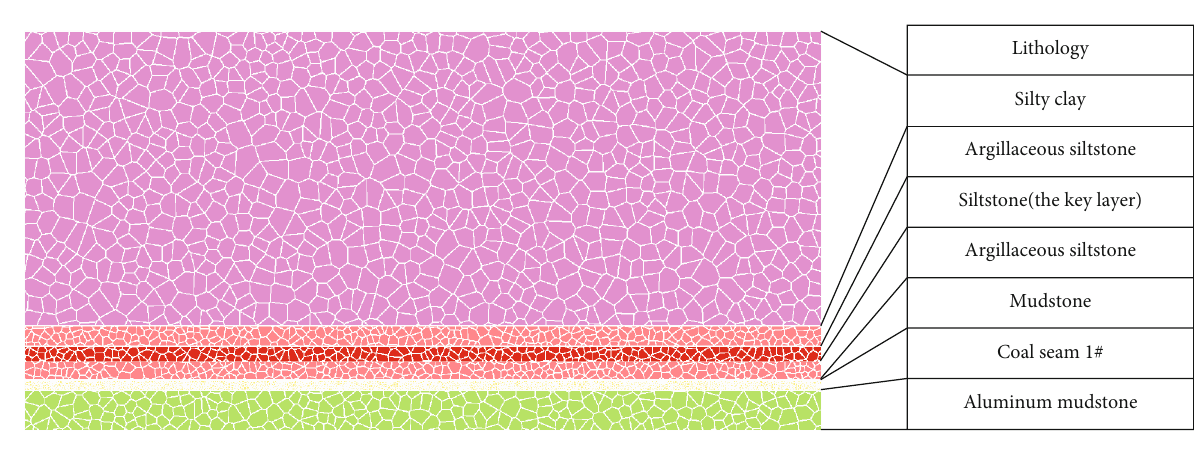
Figure 1: Lithological diagram of overlying rocks.